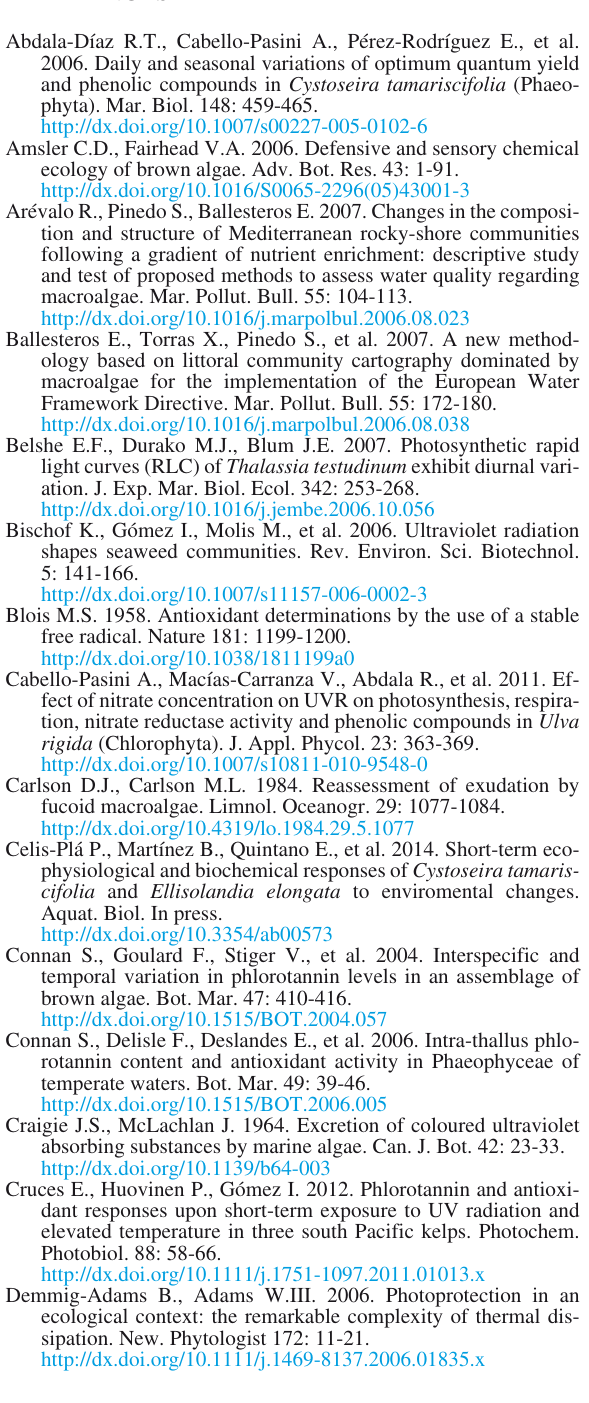
to climate change. In: Israel A., Einvav R., Seckbach J. (eds), Seaweeds and their role in globally changing environments. Springer, pp. 157-182. http://dx.doi.org/10.1007/978-90-481-8569-6_10 Figueroa F.L., Viñegla B. 2001. Effects of solar UV radiation on photosynthesis and enzyme activities (carbonic anhydrase and nitrate reductase) in marine macroalgae from Southern Spain. Rev. Chil. Hist. Nat. 74: 237-249.